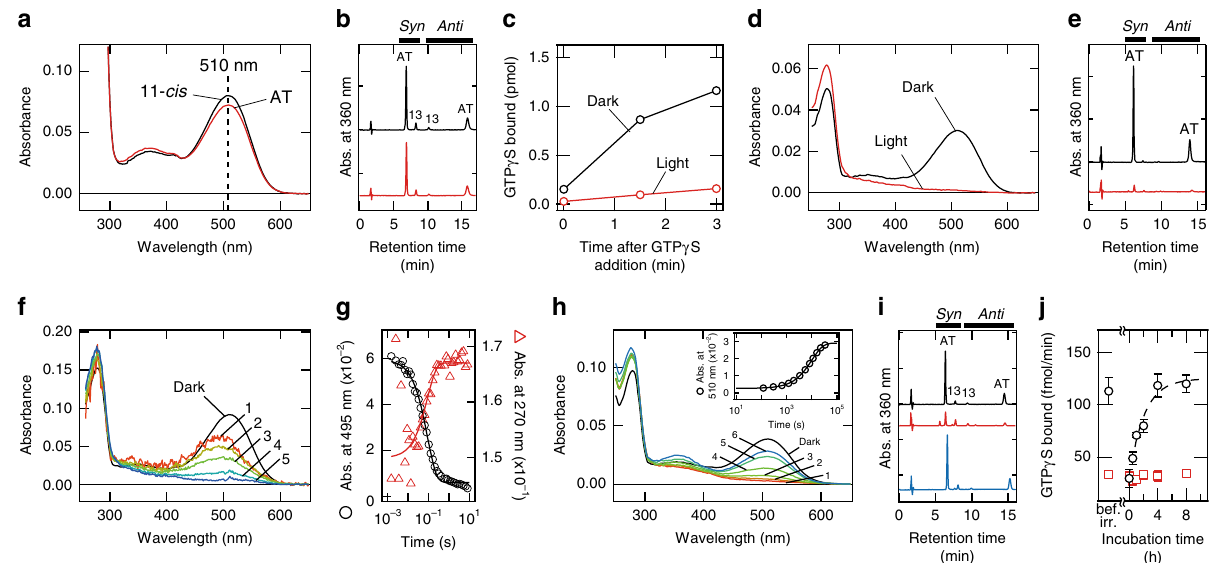
Fig. 1 Molecular characteristics of Opn5L1. a , b Absorption spectra ( a ) and HPLC patterns of retinal chromophore ( b ) of Opn5L1NC puri fi ed after incubation with 11- cis - (black) or all- trans -retinal (red). The spectra were recorded at 10 °C. c G protein activation ability of Opn5L1N before (black) and after (red) irradiation with >500 nm light for 2 min. d , e Absorption spectra ( d ), and HPLC patterns of retinal chromophore ( e ) of Opn5L1NC before (black) and after (red) irradiation with >500 nm light for 2 min. The spectra were recorded at 10 °C. f Absorption spectra before (Dark) and 0.0015, 0.017, 0.05, 0.16, and 2.1 s (curves 1 − 5, respectively) after fl ash irradiation with >500 nm light at 37 °C. g The absorbance at 495 nm (black circles) and 270 nm (red triangles) plotted against the time after fl ash irradiation. The time pro fi les were fi tted by single exponential functions y = y 0 − b × exp( − t / τ ) with the same time constant (solid curves, y = 0.0059 − 0.054 × exp( t /0.089) for 495 nm, and y = 0.167 – 0.017 × exp( t /0.089) for 270nm, τ = 0.089 s). h Absorption spectra before (Dark) and 0, 11, 32, 92, 447, and 557 min (curves 1 − 6, respectively) after irradiation with >500 nm light for 2 min at 37 °C. (inset) The absorbance at 510 nm plotted against the time after irradiation (black circles). The data were fi tted by single exponential function y = y 0 − b × exp( − t / τ ) (solid curve, y = 0.029 – 0.026 × exp( t /10500), τ = 1.1×10 4 s). i HPLC patterns of retinaloximes extracted before (black) and 2 min (red) or 11 h (cyan) after light irradiation. j Recovery of G protein activation ef fi ciency of Opn5L1N after light irradiation. G protein activation ef fi ciencies estimated with (red squares) and without (black circles) additional light irradiation were plotted against incubation time. Data points represent mean values ± s.d. ( n = 3). Kinetics of the increase of G protein activation ef fi ciency were fi tted by a single exponential function (broken line) with a time constant of 7.5×10 3